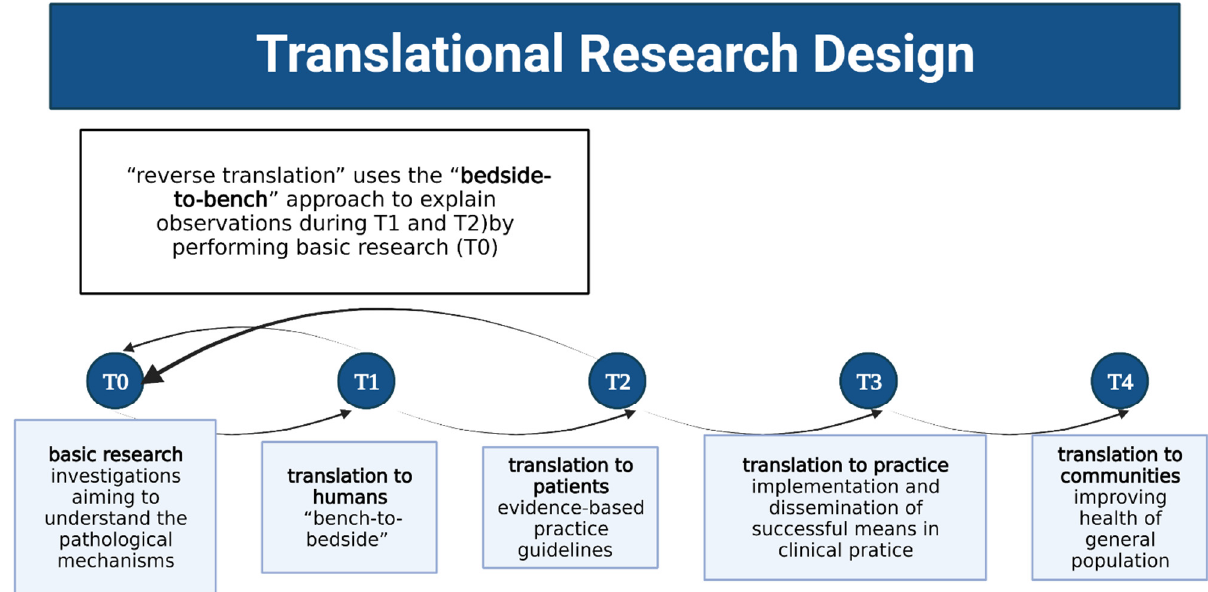
Figure 1. Types of translational research based on the description by Wichman et al. (2021) [2]. Created with BioRender.com.